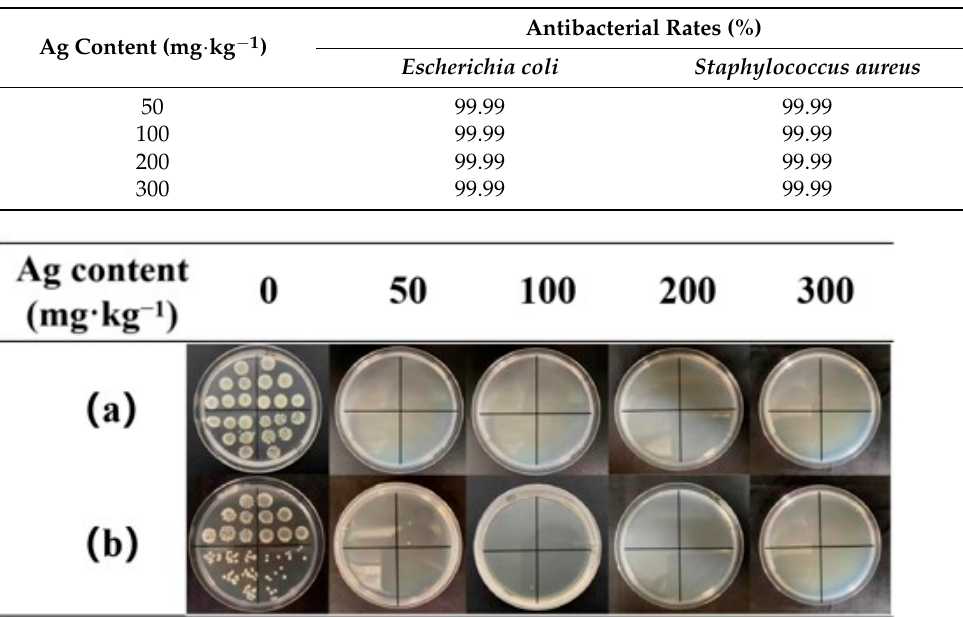
Figure 5. Petri dishes containing ( a ) E. coli and ( b ) S. aureus with TPU nanofiber membrane samples with Ag content ranging from 0 mg·kg −1 to 300 mg·kg −1 after 50 times of washing. The AgNP-embedded TPU nanofiber membrane also exhibited excellent chlorine- washing resistance. The antibacterial rates of 50 mg·kg −1 AgNP-embedded TPU nanofiber membrane against E. coli and S. aureus reached 99.99% and 99.99%, respectively, after 50 times of chlorine washing (Table 2 and Figure 6). This finding was because the core– shell-structured WPU-capped AgNPs were encapsulated in TPU nanofibers, thus effectively isolating NPs from the external environment. Table 2. Antibacterial rates of TPU nanofiber membranes with Ag contents ranging from 0 mg·kg −1 to 300 mg·kg −1 after 50 times of chlorine washing.